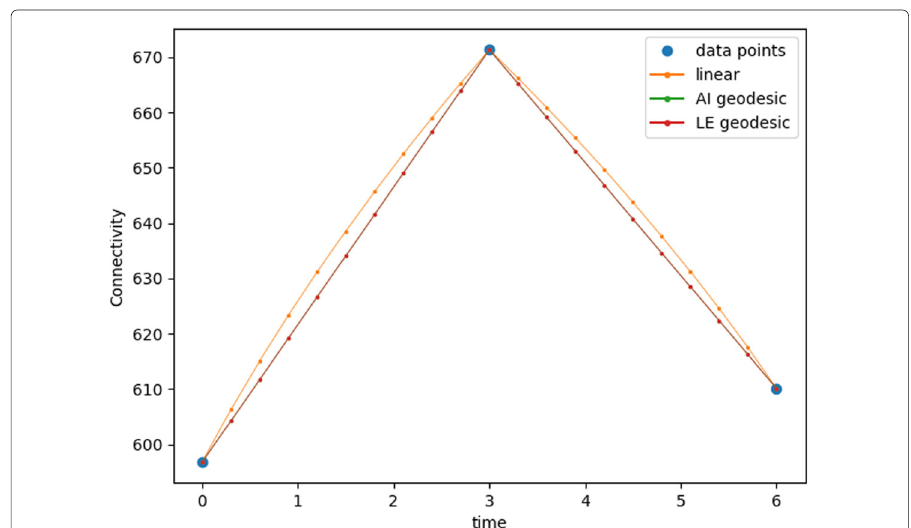
Fig. 5 Logarithm of product of non-zero eigenvalues over time with longer interpolation window (no threshold), synthetic graphs. Interpolating between graphs that are ‘farther apart’ leads to a more apparent distinction between the geodesic and linear interpolations. The AI and LE geodesic are still